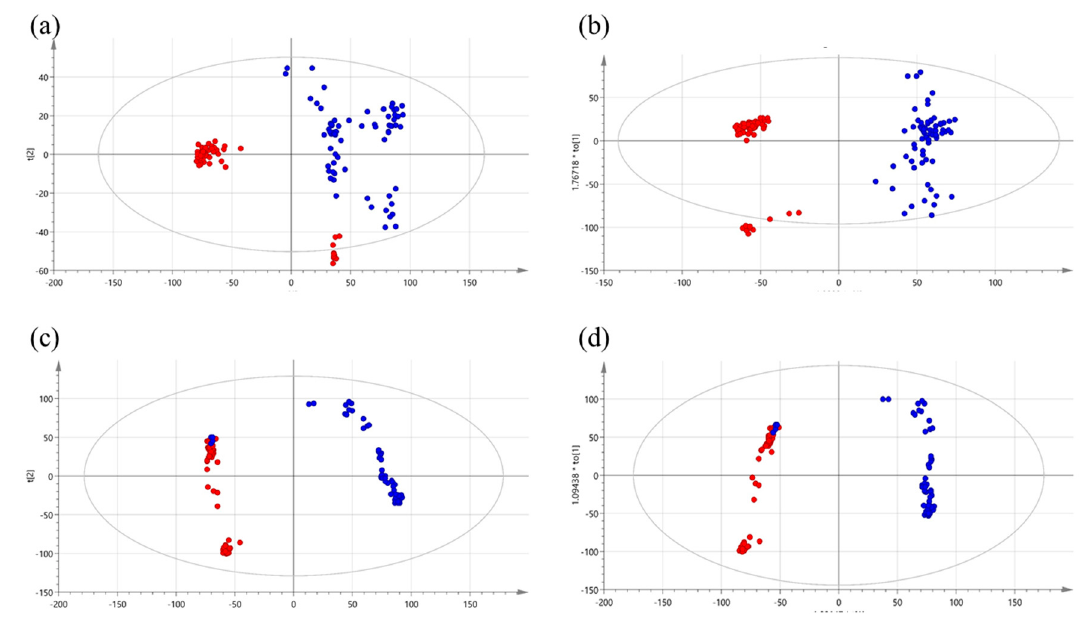
Figure 1. Score plots obtained using partial least squares discriminant analysis (PLS-DA) and orthogonal partial least squares discriminant analysis (OPLS-DA) for pre-operative (red circles) and post-operative (blue circles) patients with colorectal cancer. ( a ) PLS-DA in positive mode, ( b ) OPLS-DA in positive mode, ( c ) PLS-DA in negative mode, and ( d ) OPLS-DA in negative mode. PLS-DA, partial least squares discriminant analysis; OPLS-DA, orthogonal partial least squares discriminant analysis.